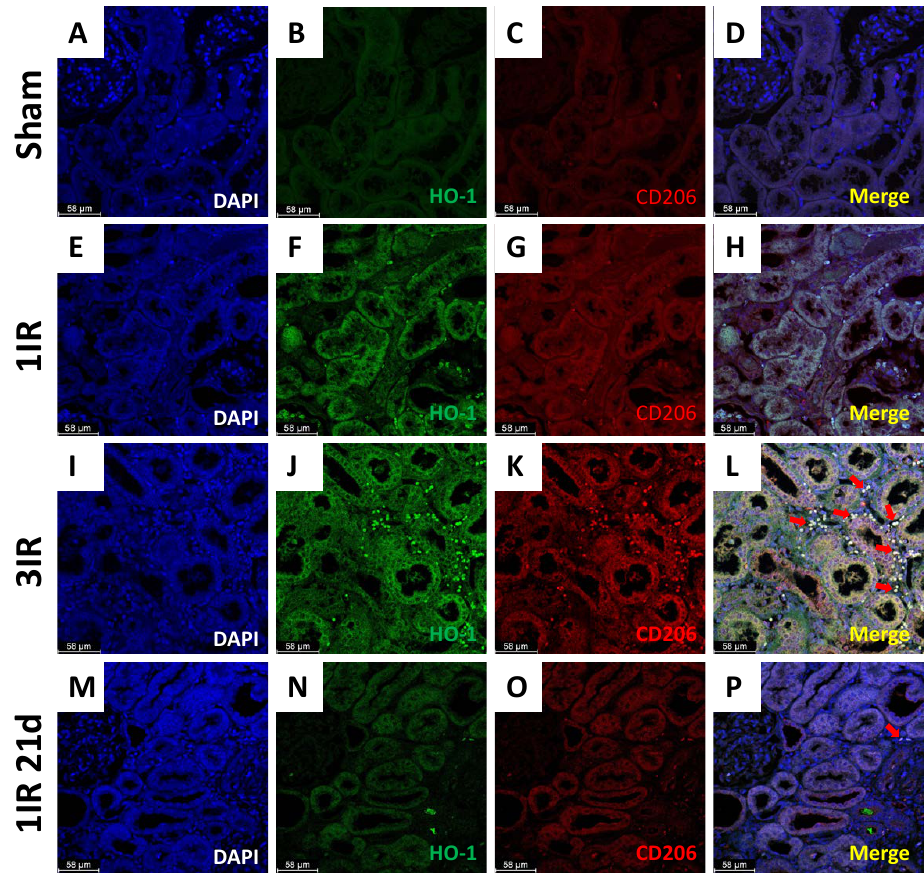
Figure 8. Immunofluorescence staining for HO-1 and CD206, a marker of M2c macrophage polariza- tion in renal tissue. ( A – D ) Representative images of renal cortex from a sham rat, ( E – H ) from 1IR rat, ( I – L ) from 3IR rat, and ( M – P ) from 1IR rats just 21 days after the ischemic insult. DAPI is in blue color, HO-1 in green, and CD206 in red. The images stated as ( D , H , L , P ) show the corresponding merge images. Bar = 58 µ m. Arrows in red show the co-immunolocalization of interstitial positive cells for HO-1 and